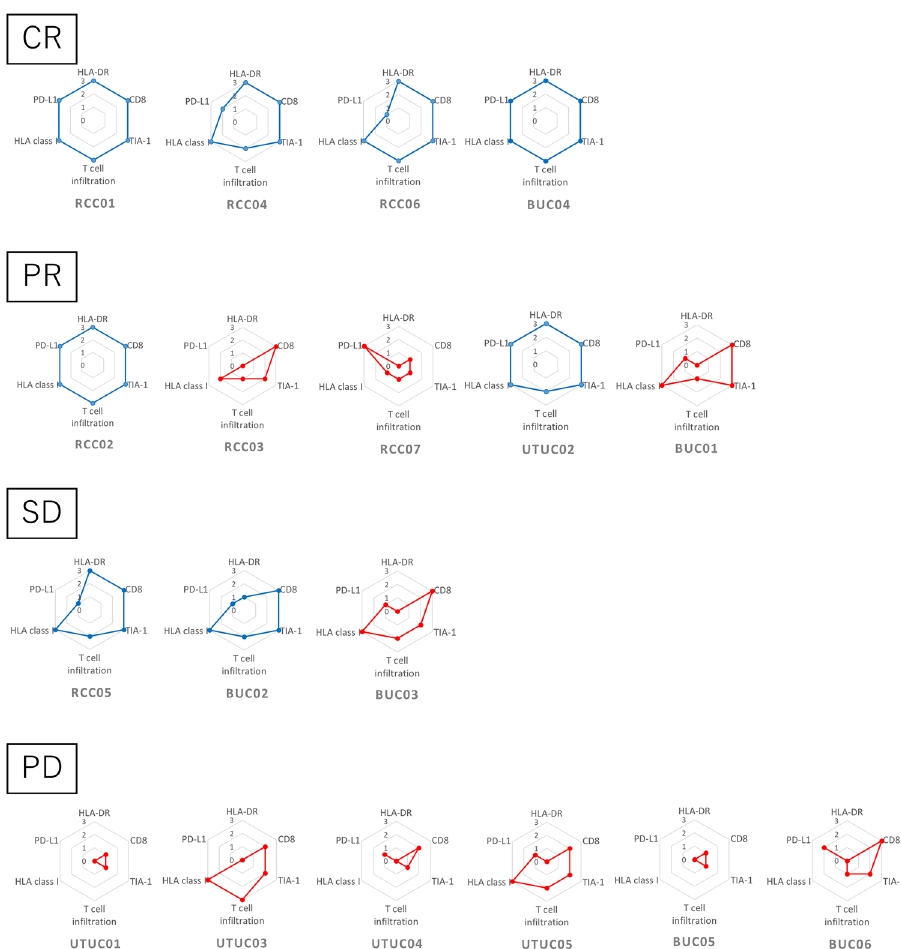
Figure 1. Immunohistograms of all patients stratified according to objective response to ICI therapy. Immunohistograms of the immune-hot group are drawn in blue lines and those of the immune-cold group are drawn in red lines. CR: complete response, PR: partial response, SD: stable disease, PD: progressive disease.